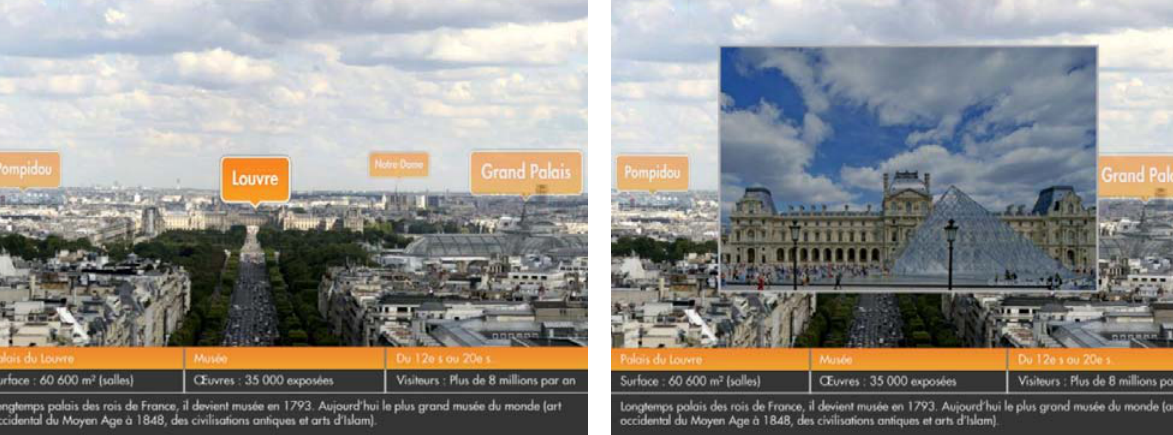
Fig. 10. (left) “ Paris, Champs Elysée ” avenue panoramic view with a global information related to the interest sites. (right) a focus on the “ Palais du Louvre ”. 6.